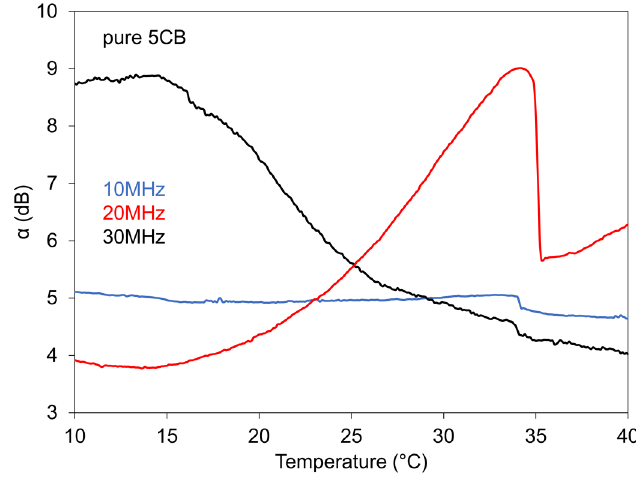
Figure 6. Dependences of SAW attenuation on temperature for pure 5CB measured at different fre- quencies.